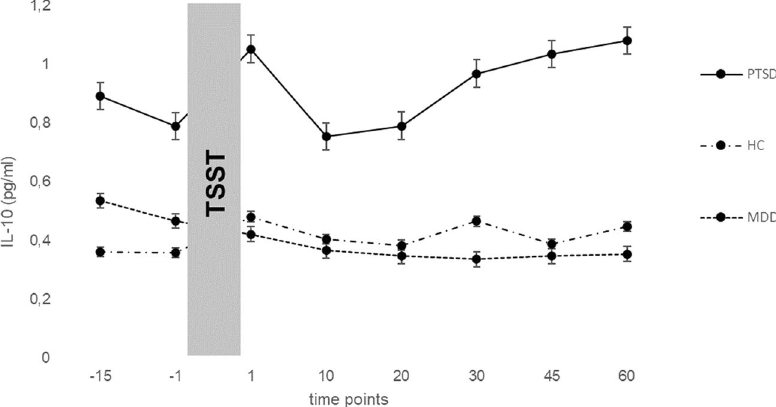
Fig. 2 Mean (±SE) IL-10 levels across measurement points of the TSST in PTSD, MDD patients and HCs. IL-6 Interleukin-6, TSST trier social stress test, PTSD post traumatic stress disorder, HC healthy controls, MDD major depression disorder, time points in levels showed signi fi cant main effects for time ( F (3.80, 182.20) = Figures 1 and 2 show mean values of IL-6 and IL-10 levels for 4.88, p = 0.001, η p2 = 0.092), a signi fi cant main effect for group ( F the measurement points of the TSST of PTSD, MDD patients and healthy controls. Results of the repeated measures ANCOVA can (2, 48) = 15.22, p < 0.001, η p2 = 0.388) and a signi fi cant interaction be derived from Table 2. Comparing IL-6 values, there was a for time x group ( F (7.59, 182.20) = 3.05, p = 0.004, η p2 = 0.113). signi fi cant main effect for time ( F (3.94, 189.25) = 9.03, p < 0.001, Bonferroni-adjusted post hoc analysis revealed signi fi cant differ- η p2 = 0.158) but not for group ( F (2, 48) = 0.08, p = 0.920). IL-10 ences in IL-10 levels between PTSD and MDD patients (0.38, p <